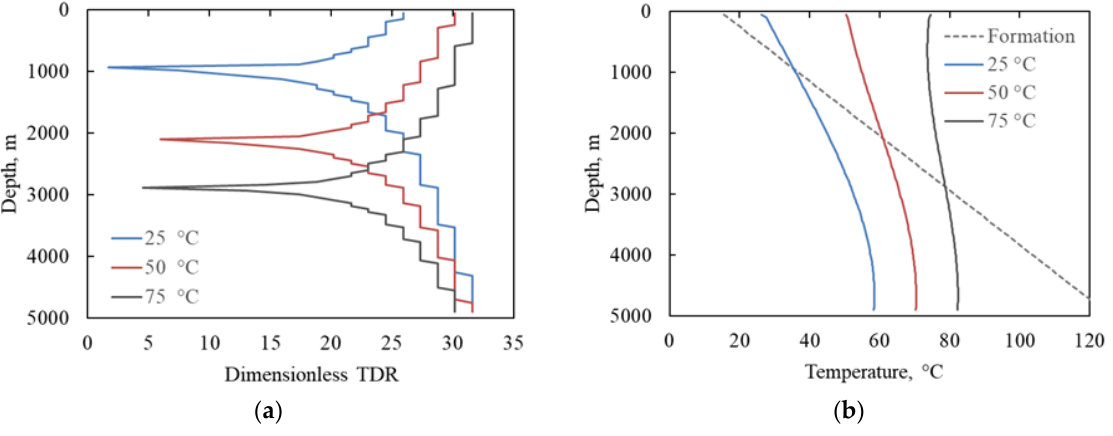
Figure 9. The sensitivity analysis of thermal disturbance with varying injection temperatures: ( a ) TDR and ( b ) fluid temperature in the annulus.